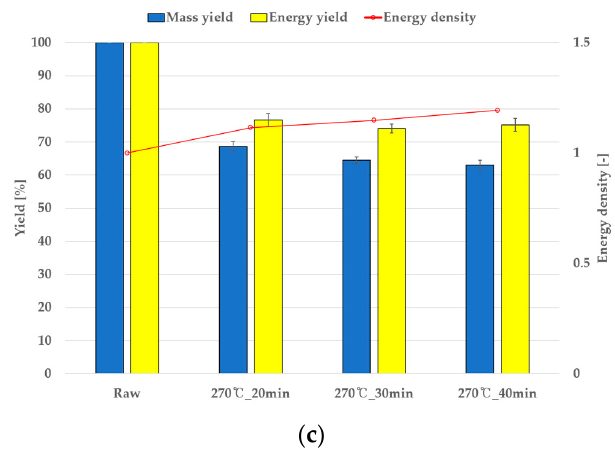
Figure 6. Grape mass and energy yields and energy density according to torrefaction process time and temperature. ( a ) At 200 °C, ( b ) at 230 °C, and ( c ) at 270 °C.